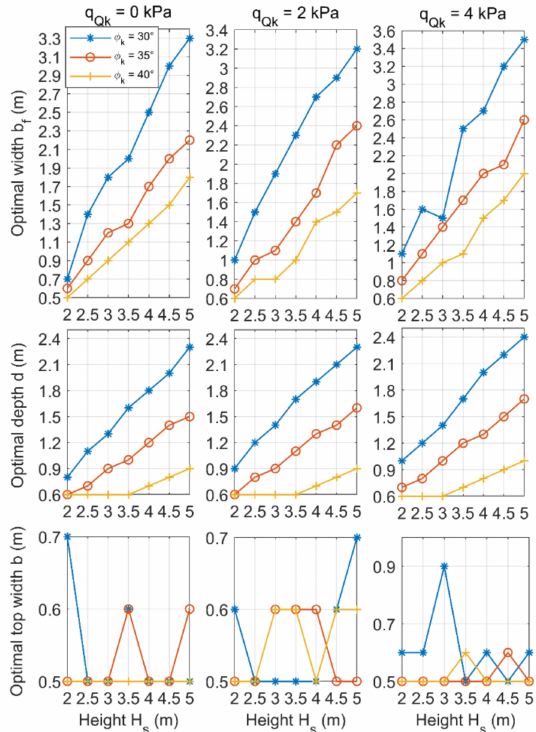
Figure 5. Optimal design for k = 0.5, β = 10 ◦ and γ = 18 kN/m 3